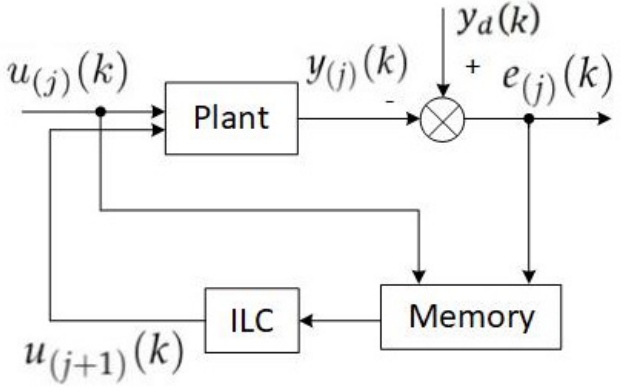
Figure 1. Basic structure of